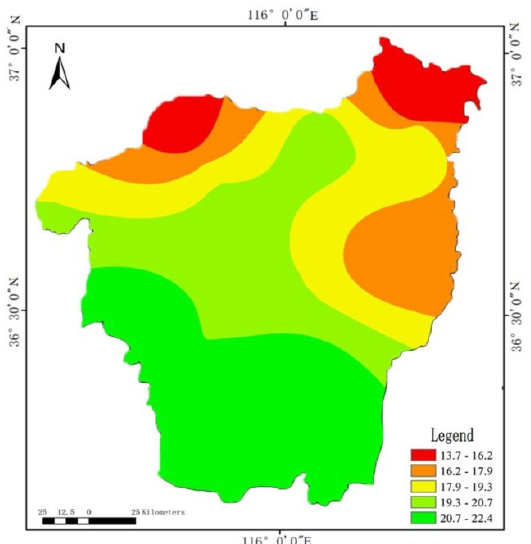
Figure 10. Spatial distribution map of comprehensive recharge coefficient.